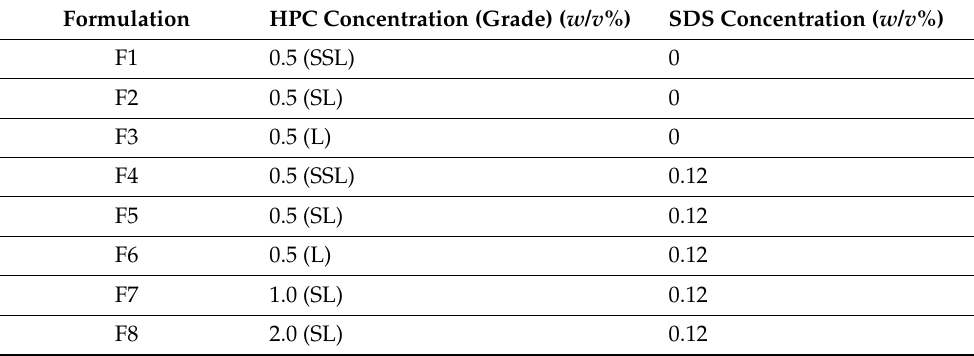
Table 1. Components of Formulations Evaluated in This Study.